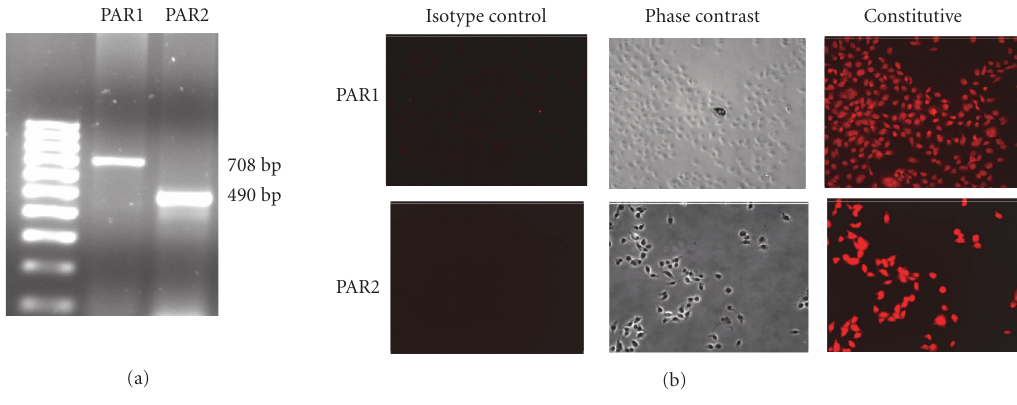
Figure 1: (a) RT-PCR analyses of the constitutive expression of PAR1 and PAR2 mRNA . Total RNA was extracted, reverse transcribed, and amplified using PAR1- and PAR2-specific primers as described under “Methods” section. The amplified products were electrophoresed on a 2% agarose gel. The result presented is representative of three independent experiments. (b) Immunoflourescence analyses of the expression of PAR1 and PAR2 proteins . The cultured HCECs were fixed with paraformaldehyde and were incubated with specific primary antibodies or isotype IgG. After extensive washing, the cells were incubated with rhodamine-conjugated secondary antibodies and viewed under a fluorescence microscope for